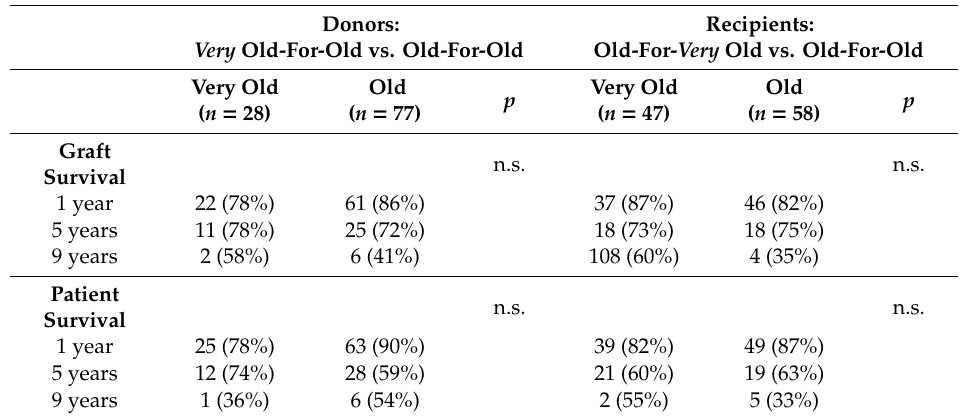
Table A2. Mortality table with age-dependent comparison stratified for donor age (very old donors